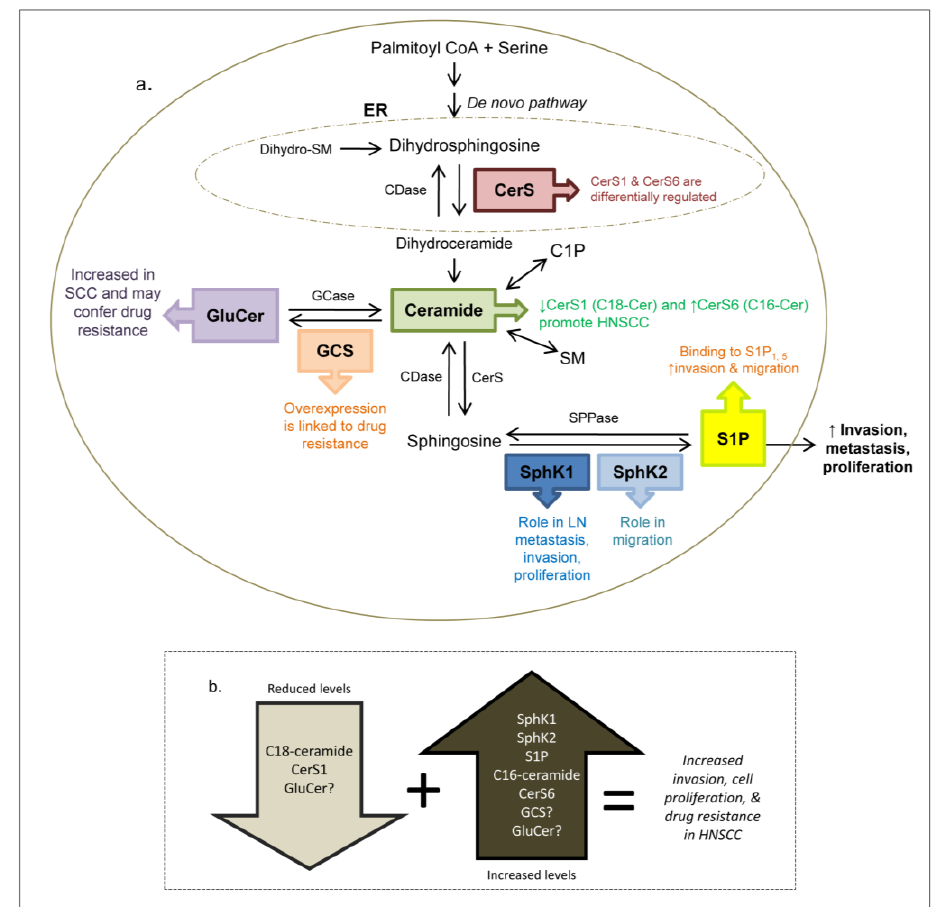
Figure 2. Overview of sphingolipid enzymes and metabolites and their influence on HNSCC. ( a ) S phK1 is positively associated with increased lymph node (LN) metastasis [32], proliferation [11] and resistance to radiation-induced cell death. ( b ) Perturbation of specific sphingolipid players affects invasion, proliferation and drug resistance in HNSCC. Abbreviations: SPPase (sphingosine phosphate phosphatase), GCS (glucosyl ceramidase), GCase (glucosyl ceramidase), CDase (ceramidase), CerS (ceramide synthase), C1P (ceramide 1-phosphate), SM (sphingomyelin), ER (endoplasmic